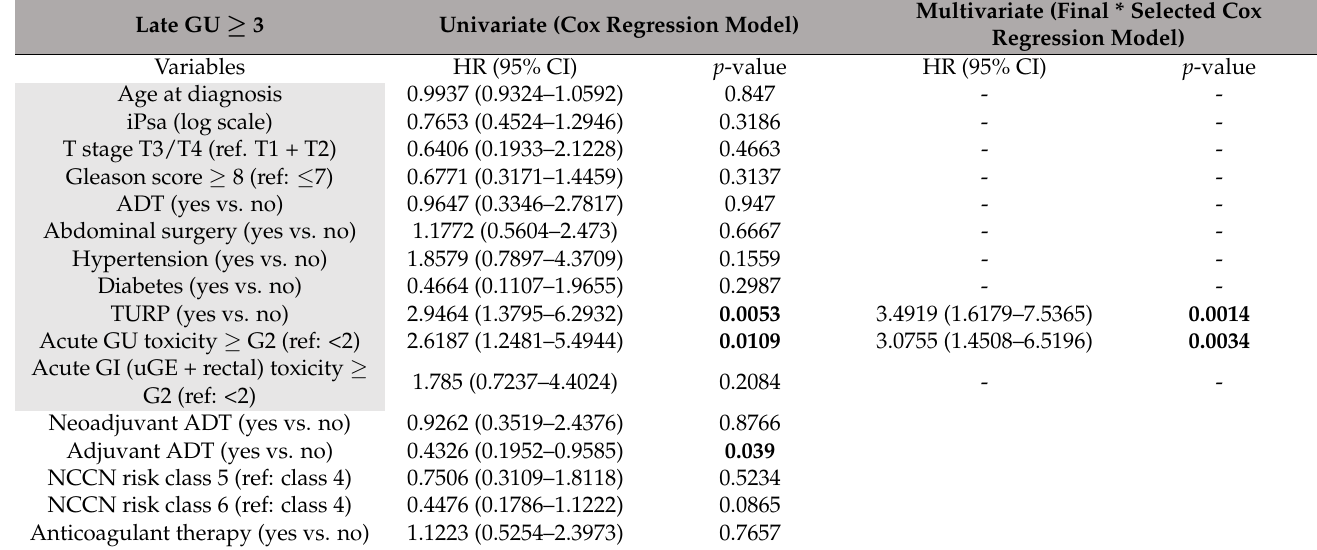
Table 5. Univariate and multivariate analysis of factors influencing